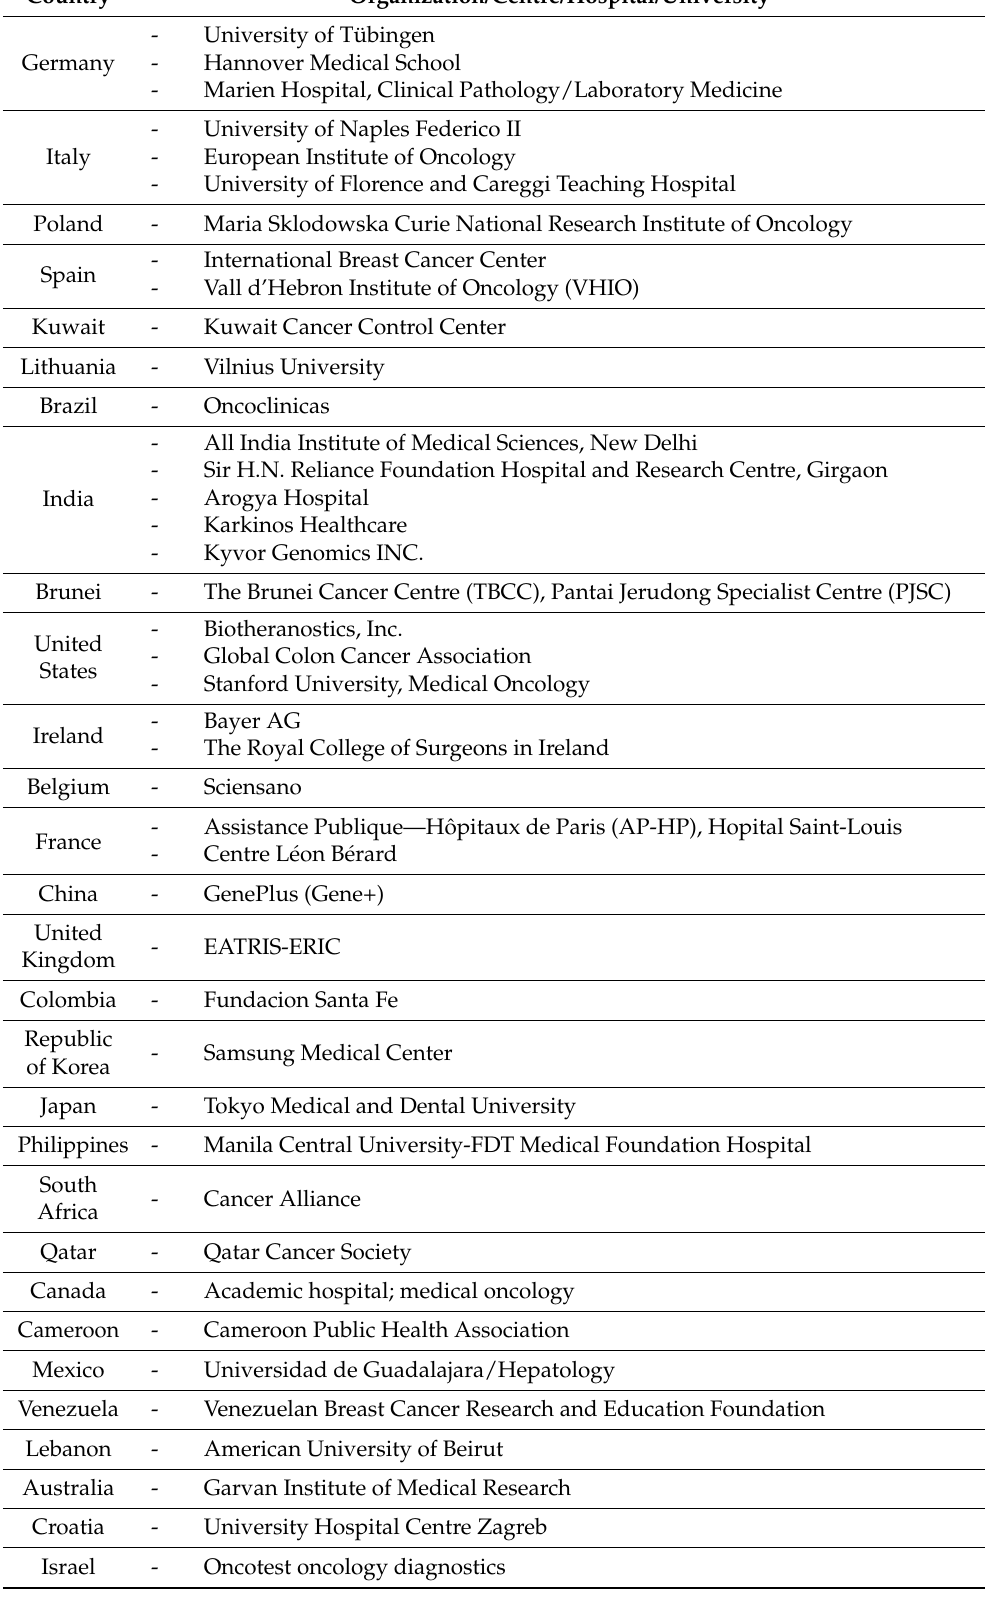
Table A8. List of different centres/universities/hospitals from different countries involved in the survey.